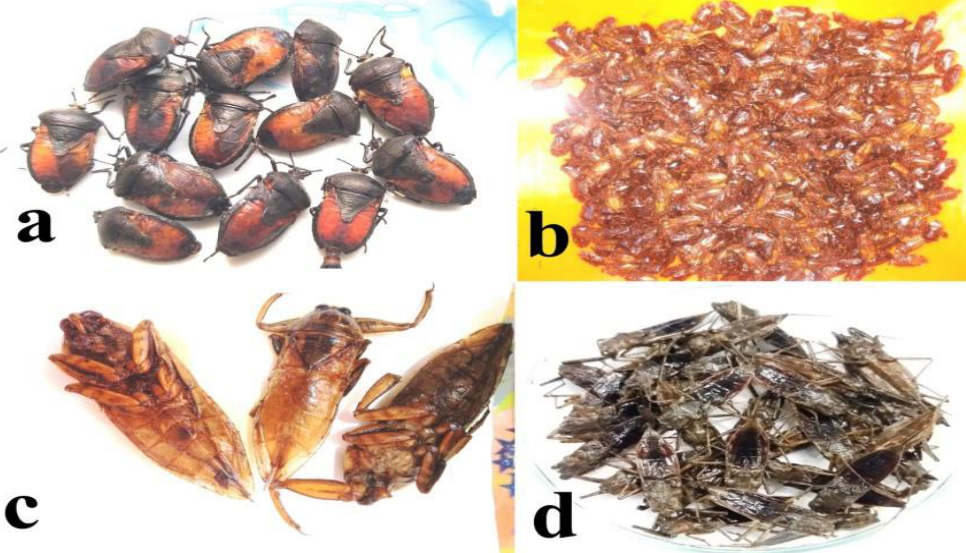
Figure 6. ( Plate 4 ). Mode of preparation of various hemipterans: ( a ) roasted stink bugs ( Coridius singhalanus ), ( b ) fried pentatomid bug ( Udonga montana ), ( c ) fried giant water bugs ( Lethocerus indicus ), ( d ) boiled water scorpions ( Laccotrephes ruber